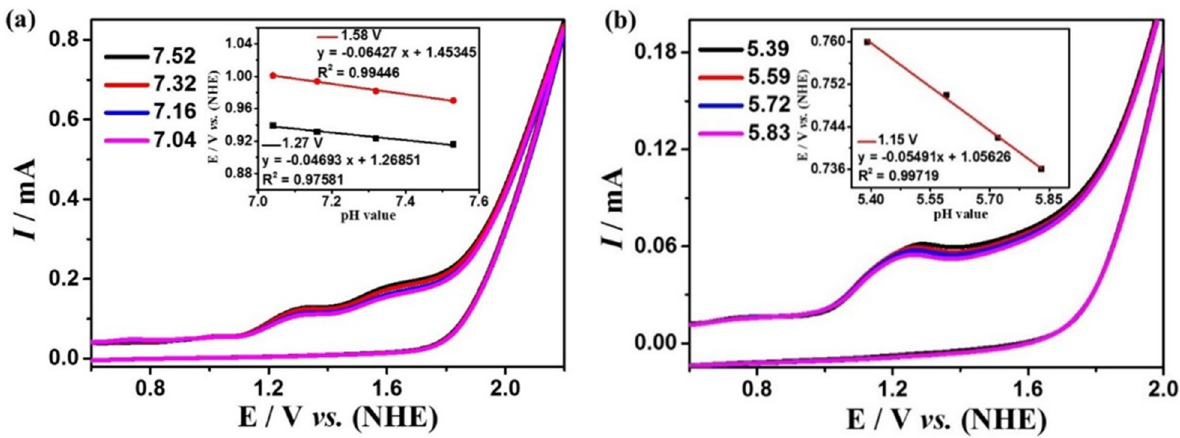
Figure 3. Cyclic voltammograms of 0.5 mM complexes 1 ( a ) and 2 ( b ) in DMF:water (3:7 v / v ) solution with 0.2 M phosphate buffer at different pH (scan rate 100 mV s − 1 ). The insets of ( a ) and ( b ) are the relationships of onset potentials for electrocatalytic water oxidation with pH values.